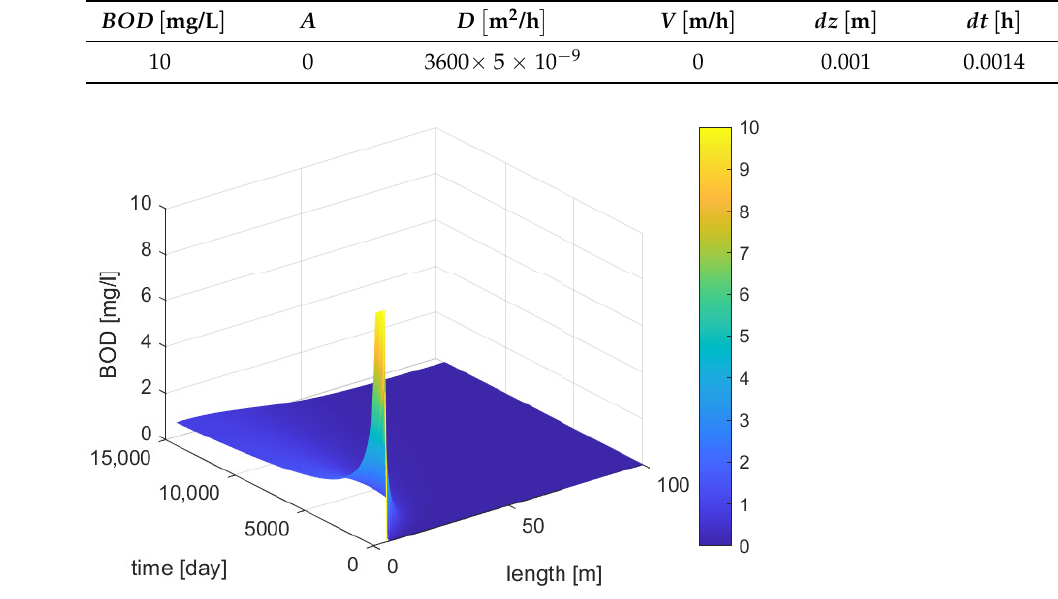
Figure 3. Distribution of BOD including diffusion.